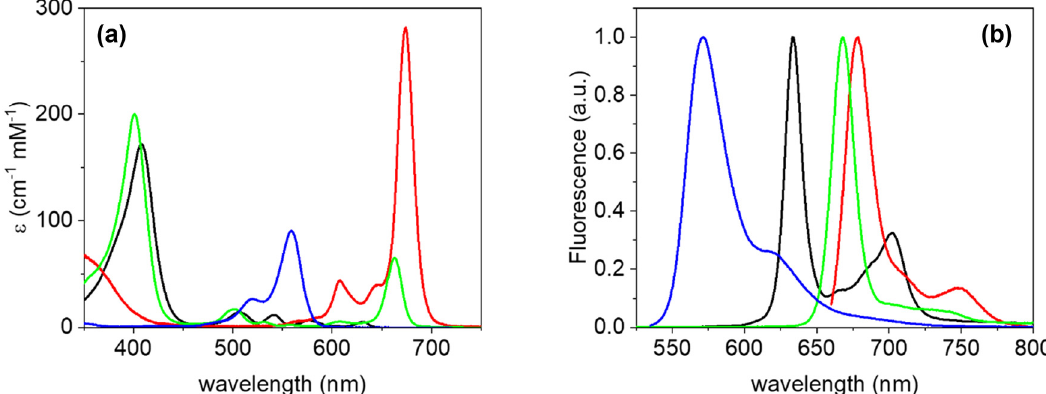
Figure 7: Representative absorption and fl uorescence emission spectra by selected photosensitizing molecules. Molar absorption coe ffi - cients ( a ) and normalized fl uorescence emission ( b ) spectra for protoporphyrin IX dimethyl ester in chloroform ( black ) , zinc phthalocyanine in pyridine ( red ) , Chlorin e6 in ethanol ( green ) , and rose bengal in basic ethanol ( blue )